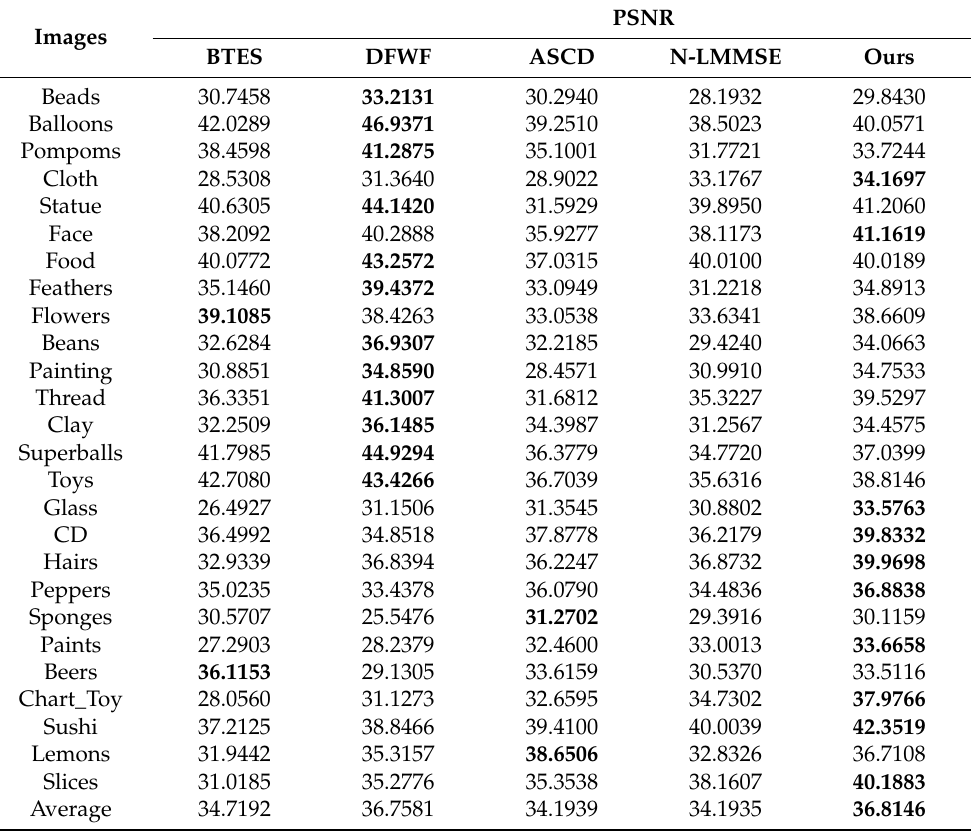
Table 2. The PSNR average results of demosaicking algorithms.